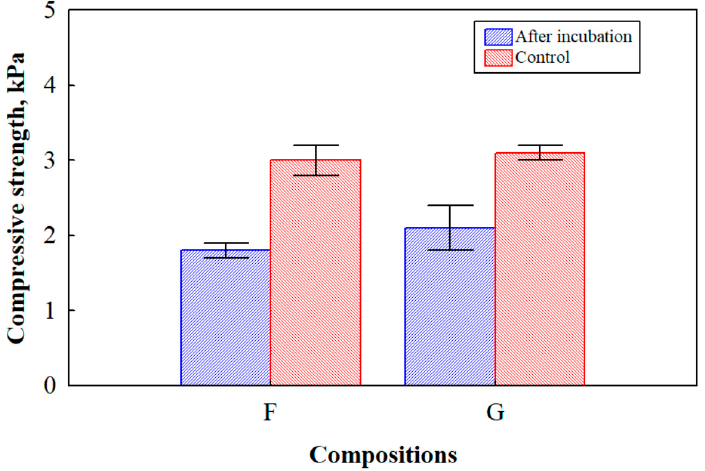
Figure 8. Compressive strength of BcBs before and after incubation for 6 months with mix of P. putida and Rh. oryzae . Measurements for F and G compositions with or without inoculation (control) with microorganisms are demonstrated. Experiments were performed in triplicate, and the average values and standard deviations are shown.